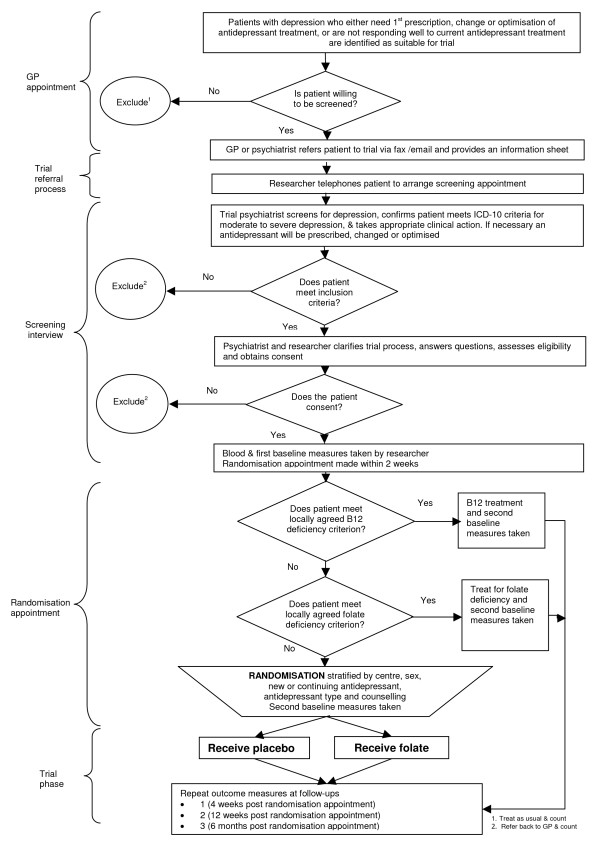
Flow diagram of trial.